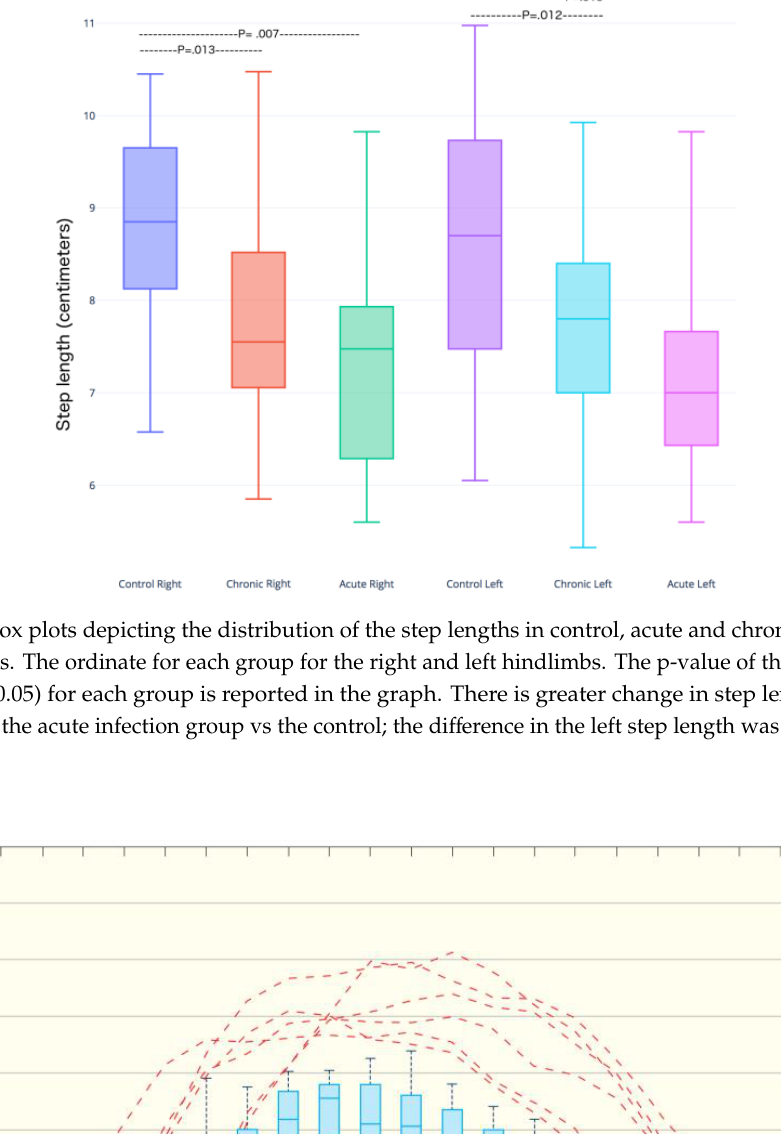
Figure 5. Control mice metatarsal joint displacement in boxplots. Dashed lines indicate a qualitative comparison between control and mouse 7. The red lines show the dissimilarity existing between the cycle percentages in the mice of the acute-infected group compared to the control group.